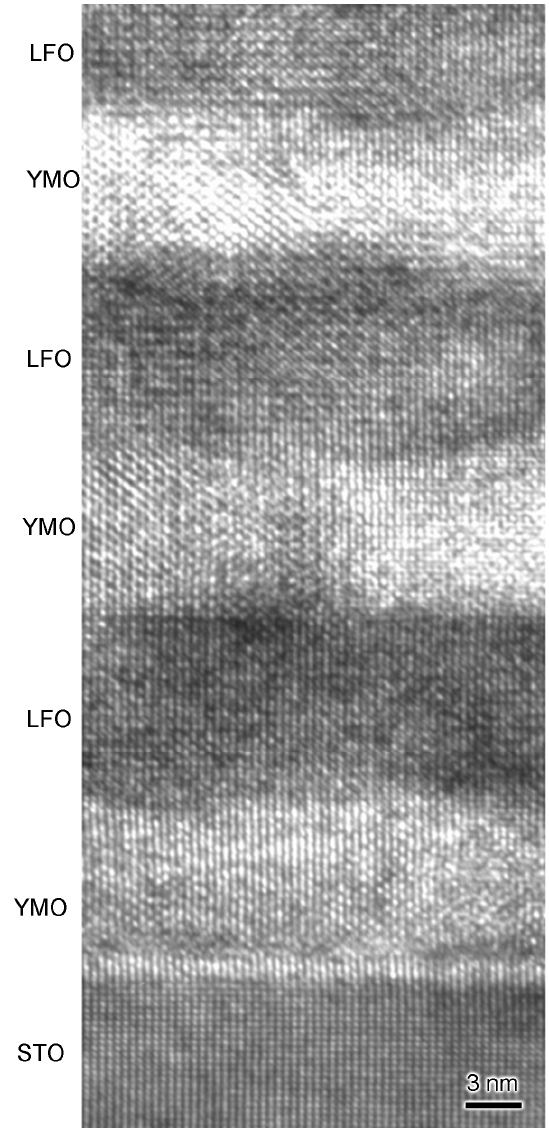
Figure 8. HRTEM image of sample-III. This image was taken with electron beam aligned along the [11-2]-STO zone axis.